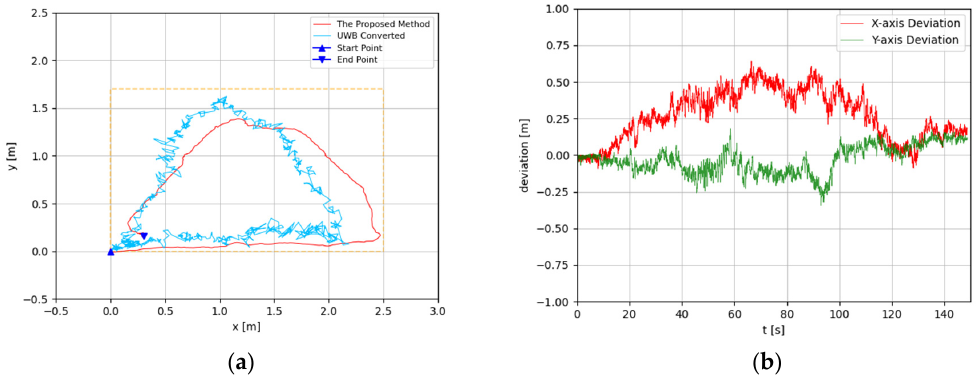
Figure 10. ( a ) Trajectory of triangle-shaped path in the first test; ( b ) Positioning comparison of rectangle-shaped path in the first test.